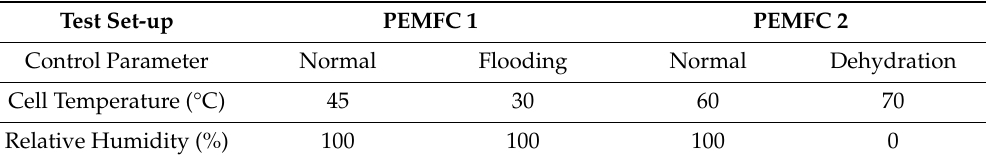
Table 10. Test set-up at two faulty conditions.